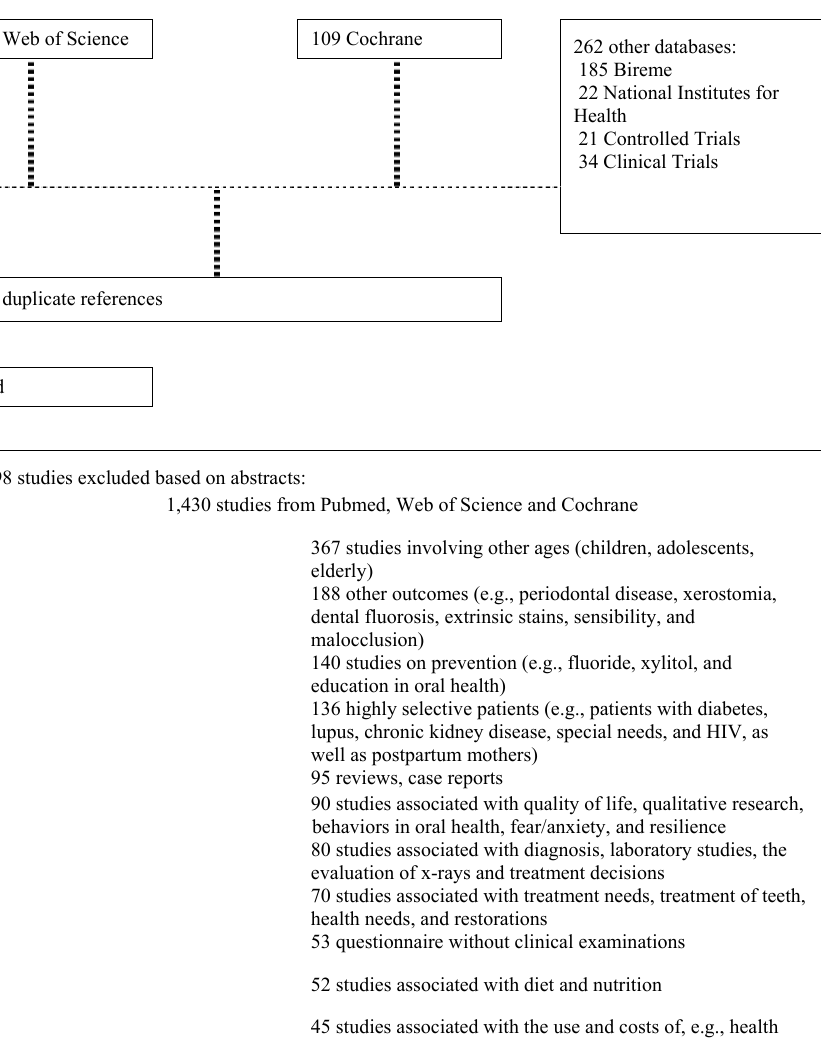
Figure 1. Flowchart of study